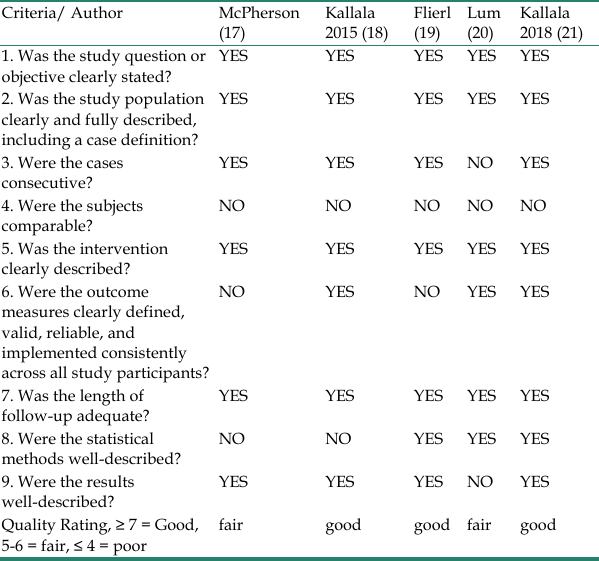
Table 1. The result of the quality